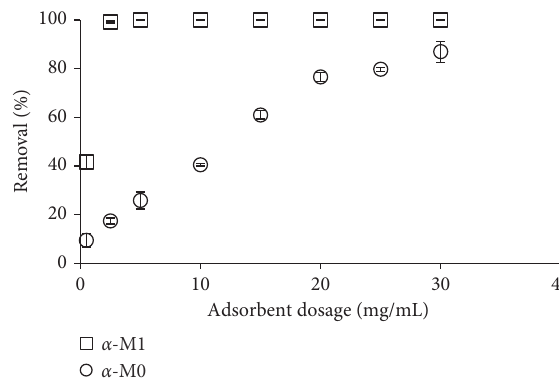
Figure 3: The effect of adsorbent dosage on RhB removal using α - M 0 and α - M 1 materials at 1mM NaCl (C i (RhB) � 10 − 5 M, pH 4, and contact time of 30min).